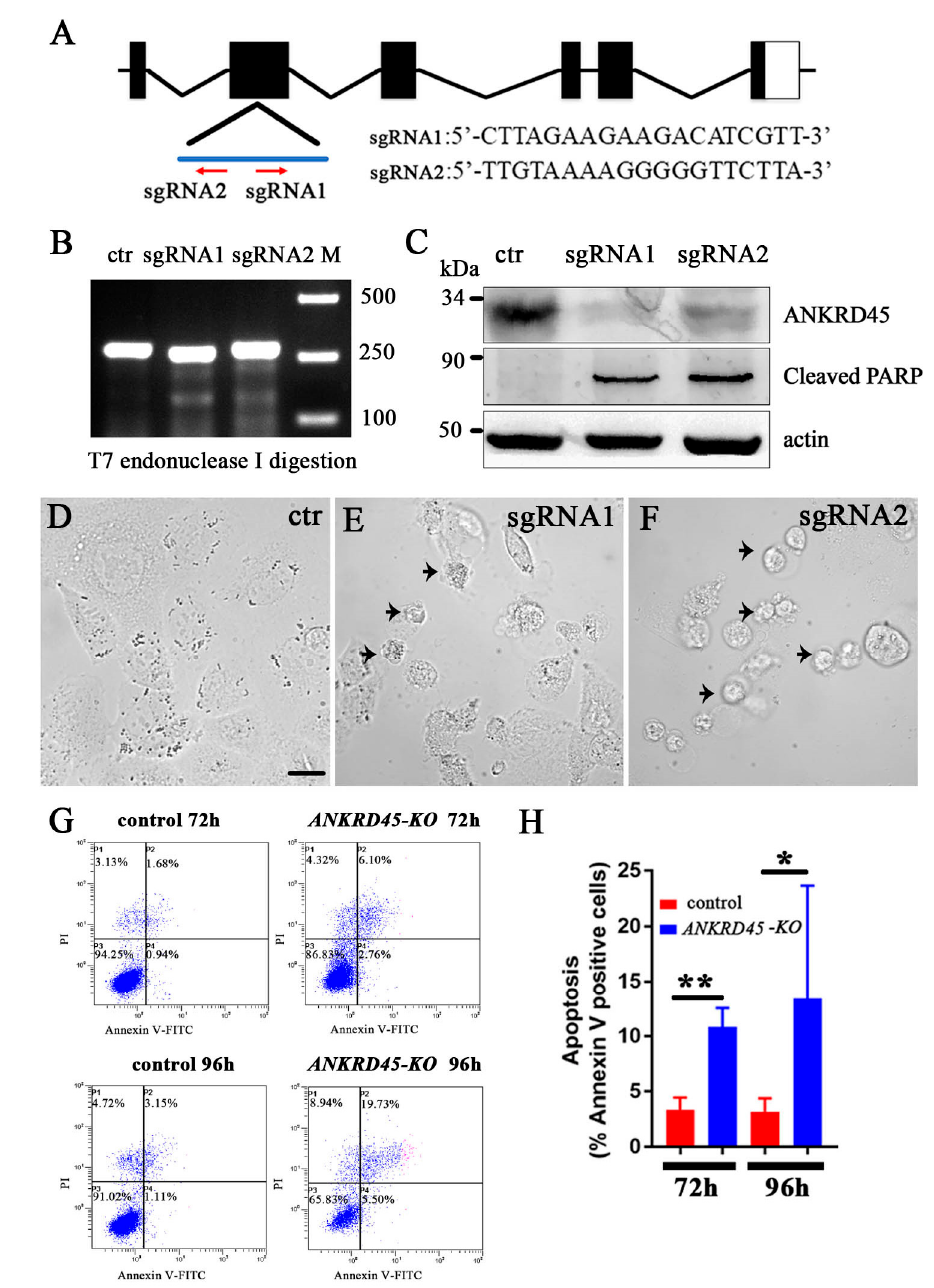
Figure 5. Transient knockdown of ANKRD45 with the CRISPR / Cas9 system results in cell apoptosis. ( A ) Genomic structure of the human ANKRD45 gene and sequences of two sgRNAs. Red arrows indicate the position and direction of the two sgRNAs. ( B ) E ffi ciency of the two sgRNAs analyzed by T7 endonuclease I digestion (T7EI). ( C ) Western blotting results showing the knockdown e ffi ciency of two ANKRD45 -targeting sequences. Both targets led to the reduction of ANKRD45 expression and increased the level of the cleaved PARP. ( D – F ) DIC images showing Hep3B cells transfected with control or ANKRD45 targeting constructs containing di ff erent sgRNAs as indicated. Arrowheads represent the apoptotic cells. ( G ) Flow cytometry analysis of Annexin V-FITC and propidium iodide staining of Hep3B cells transfected with sgRNA or empty vectors. ( H ) Bar graph showing the percentages of Annexin V positive cells at 72 hours and 96 hours after transfection with control or sgRNAs as indicated. * p < 0.05, ** p < 0.01, Scale bar: 25 μ m.